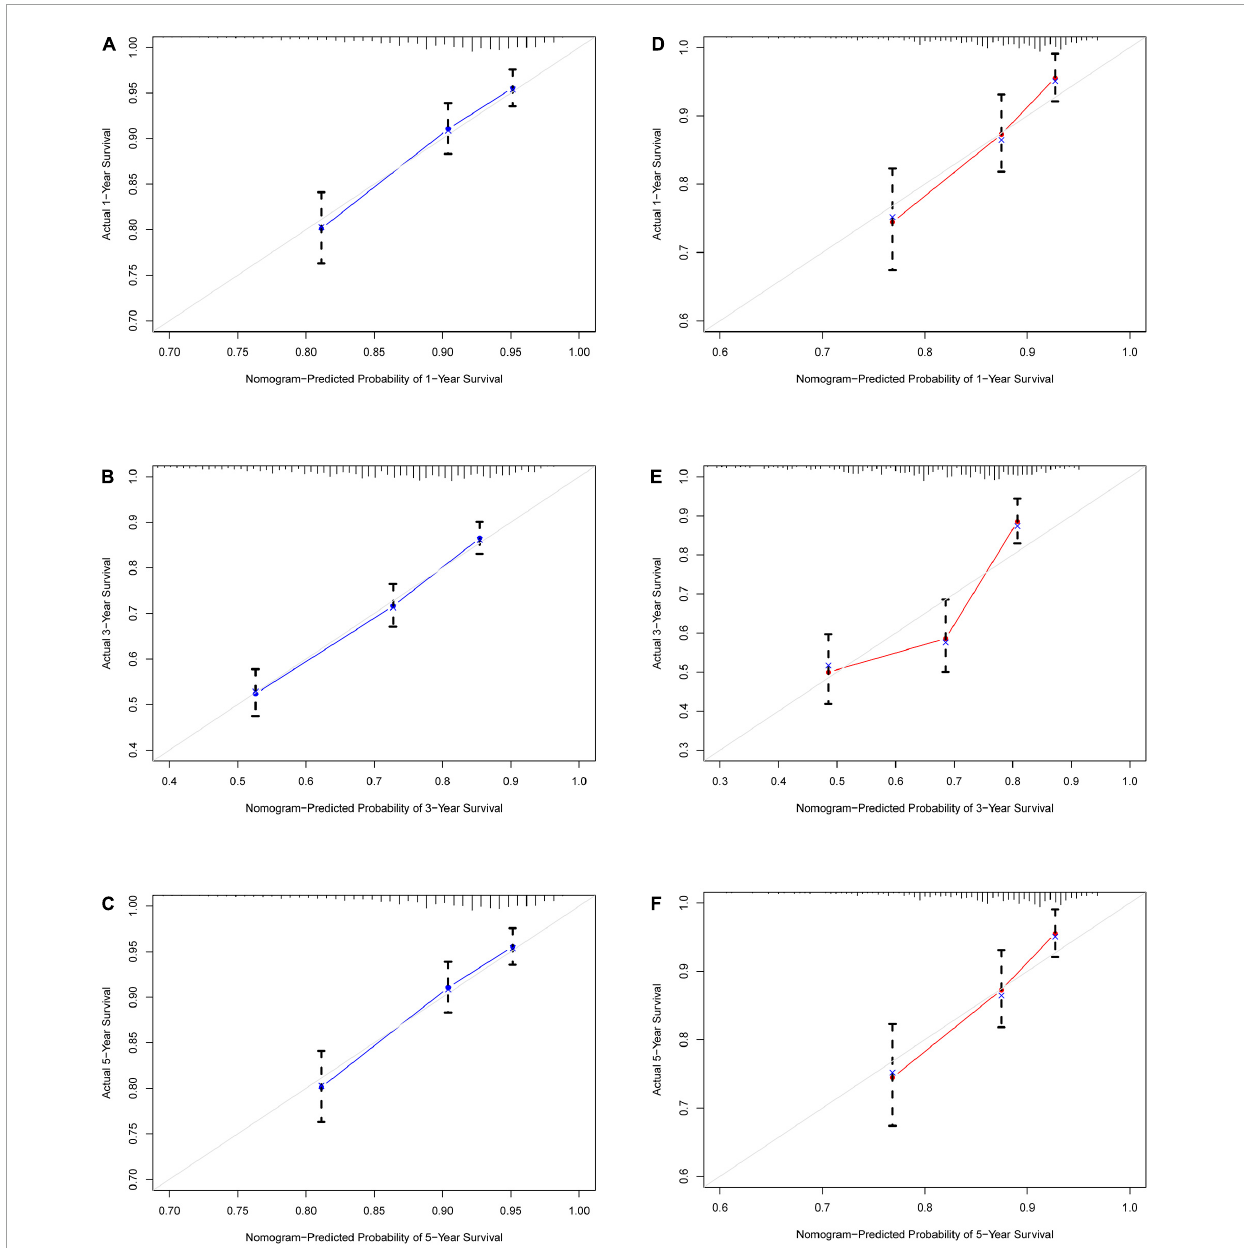
FIGURE5 Calibration curve for IHD 1-, 3-, and 5-year mortality risk prediction in the array. (A) Training set 1 year. (B) Training set 3 years. (C) Training set 5 years. (D) Validation set 1 year. (E) Validation set 3 years. (F) Validation set 5 years. The x-axis represents the predicted incidence risk. The y-axis represents the actual diagnosed CHD. The diagonal dotted line represents a perfect prediction by an ideal model. The solid line represents the performance of the nomogram; a closer fit to the diagonal dotted line represents a better